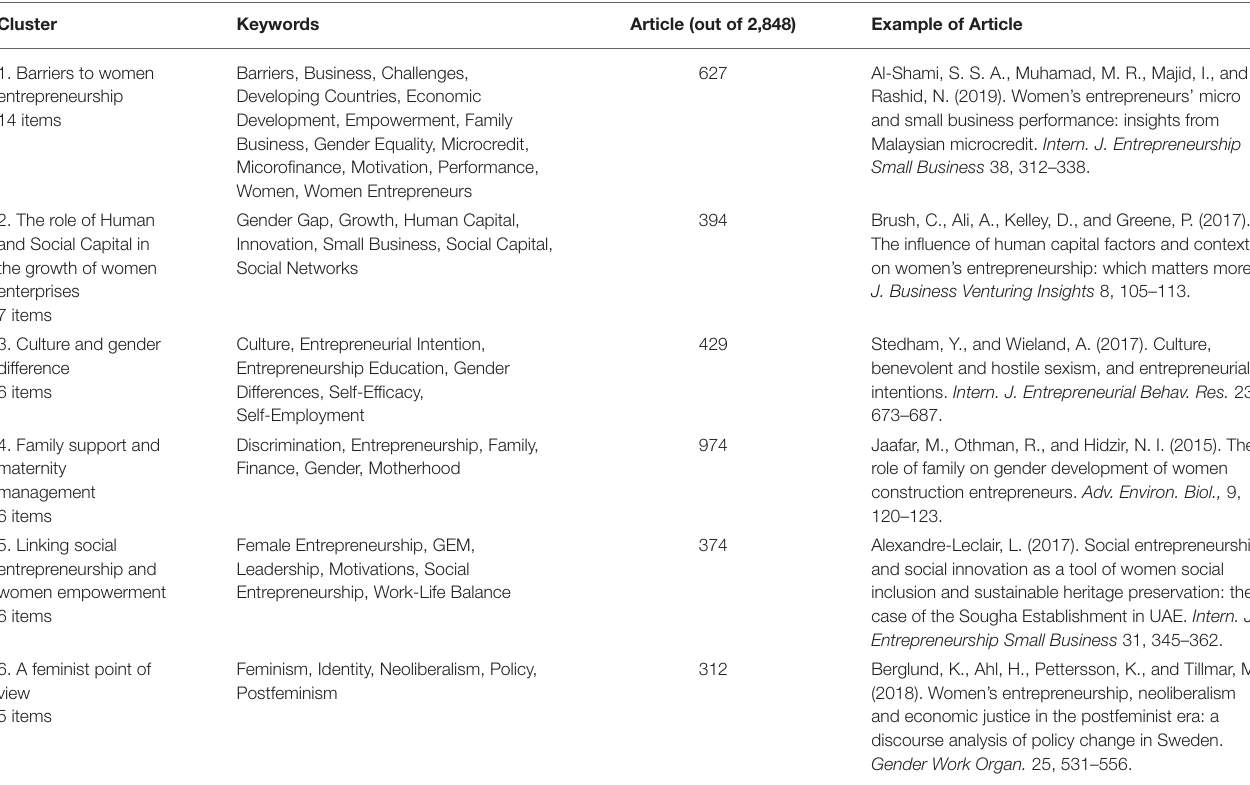
TABLE 3 | Different clusters of scientific literature.